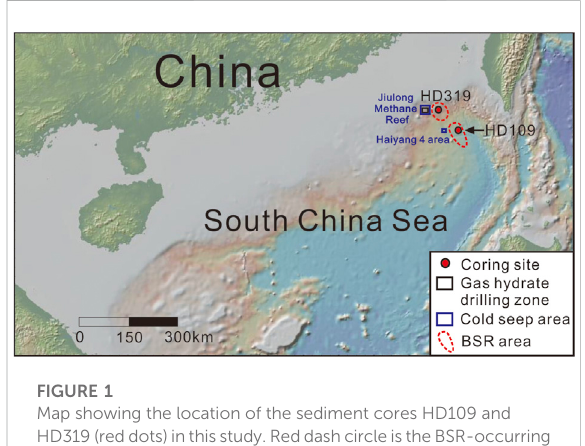
FIGURE 1 Map showing the location of the sediment cores HD109 and HD319(reddots)inthisstudy.ReddashcircleistheBSR-occurring area mapped by Ge et al. (2010) and Wu et al.